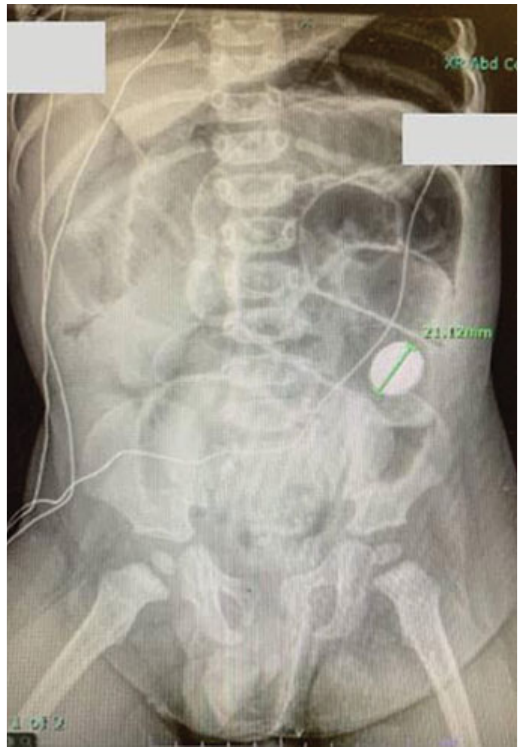
Fig. 1 KUB X-ray on postoperative day 5. A 21mm disc battery is located in the left lower quadrant and pneumoperitoneum is evident.